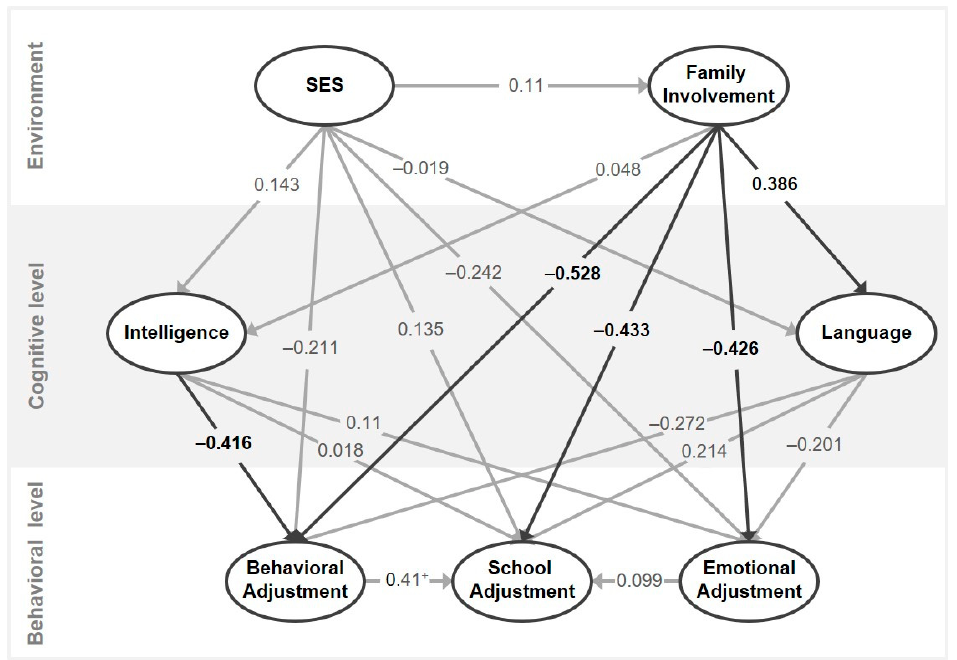
Figure 4. Model displaying the relations between the variables included in the model, which parallels the one by Morton (2004). Numbers represent path coe ffi cients ( β ), and both paths and numbers in bold reflect significant e ff ects among constructs. + indicates a marginal e ff